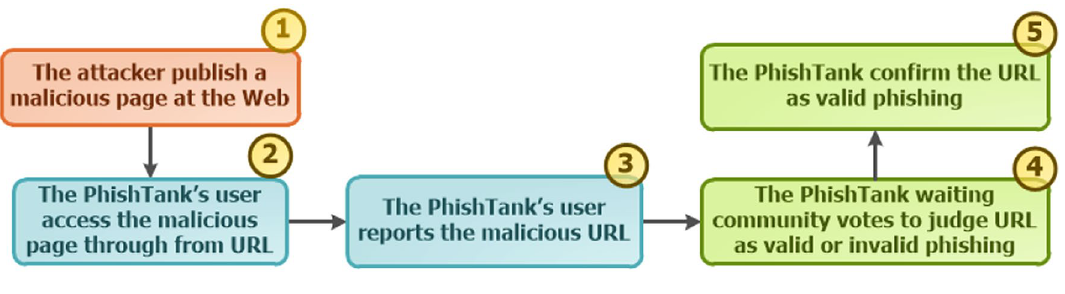
Figure 2. Lifecycle of the PhishTank Community